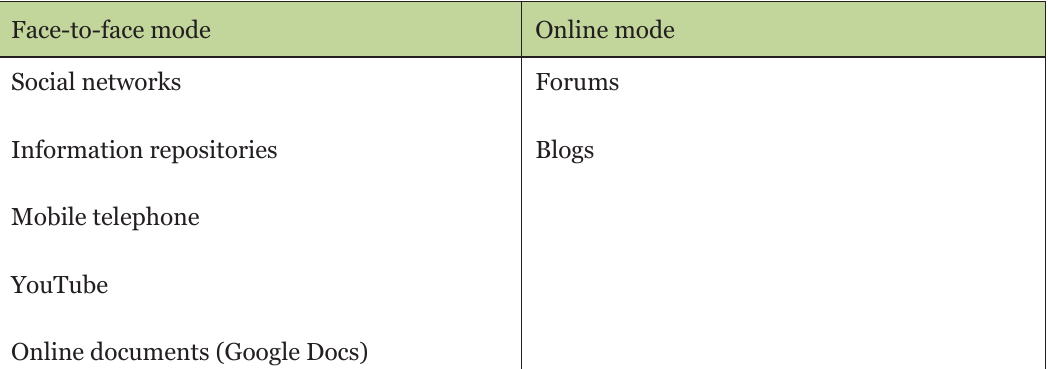
Uses of ICT in Academic